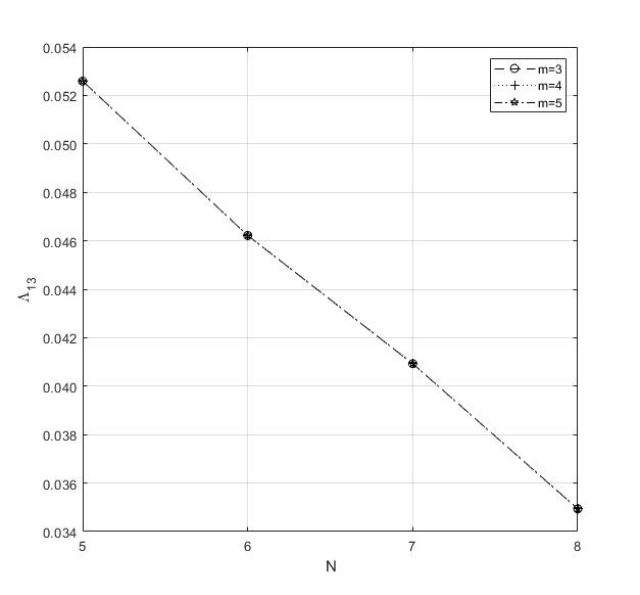
Figure 6. Impact of m and µ 2 on the E [ W h ] .